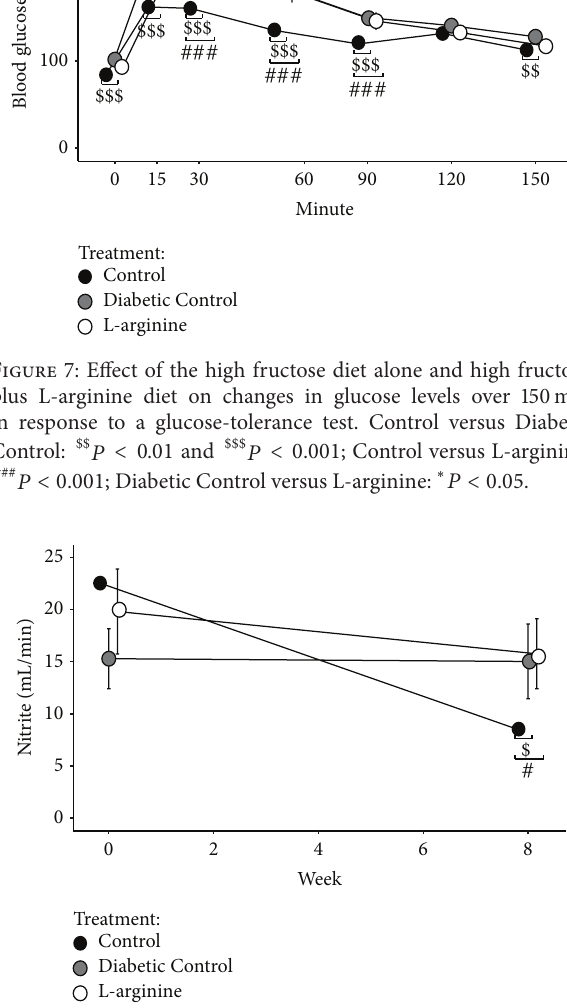
Figure 8: Effect of the high fructose diet alone and high fructose plus L-arginine diet on nitrite over 8 weeks. Control versus Diabetic Control: $ 𝑃 < 0.05 ; Control versus L-arginine: # 𝑃 < 0.05